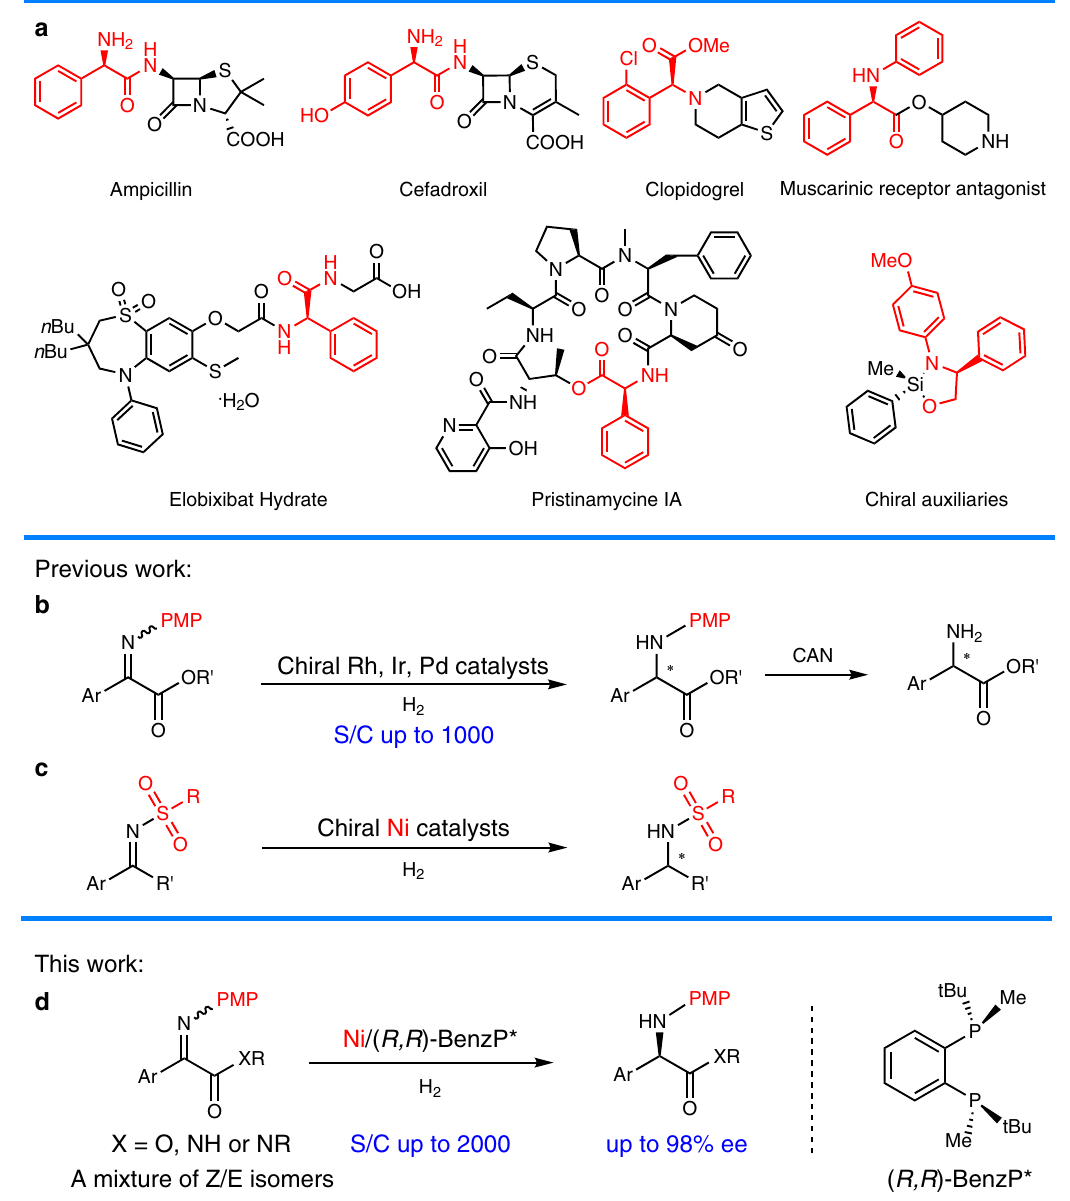
Fig. 1 Asymmetric hydrogenation of N -aryl imino esters for the synthesis of chiral α -aryl glycines. a Representative chiral products bearing chiral α -aryl glycine skeletons. b Previous work about asymmetric hydrogenation of N -aryl imino esters. c Previous work about Ni-catalyzed asymmetric hydrogenation of activated imines. d This work: Ni-catalyzed asymmetric hydrogenation of imino